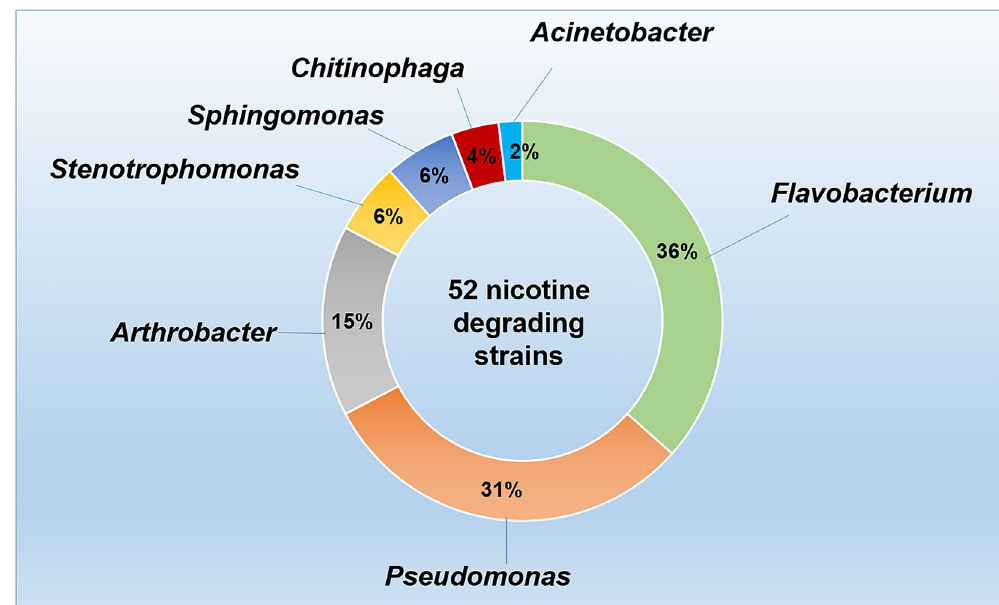
Fig. 1 Diversity of nicotine-degrading bacteria isolated from the tobacco rhizosphere soil